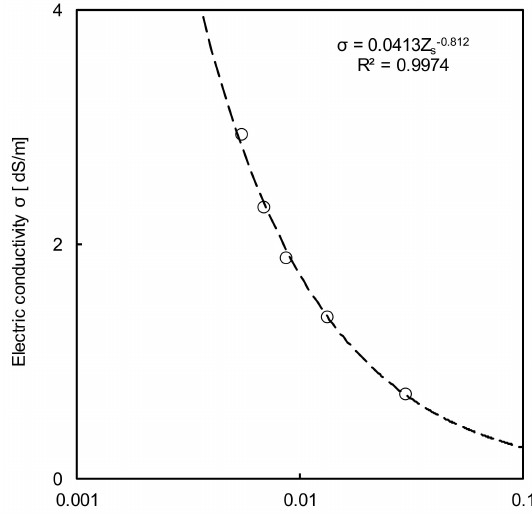
Figure 8. The calibration result of the 4 electrode resistivity probe (4ERP).